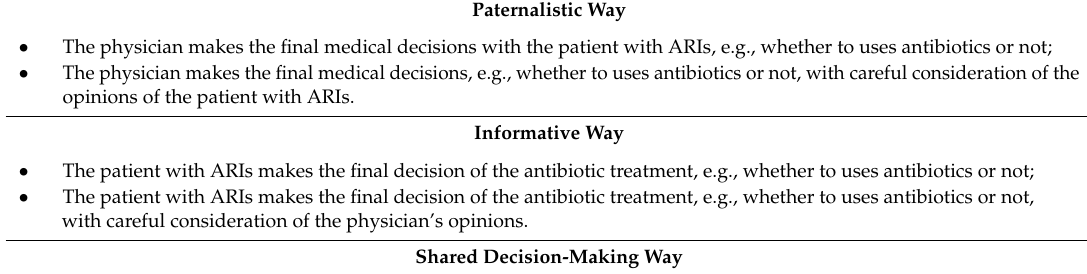
Table 1. Physicians’ intention of involving patients in medical decisions with patients with acute respiratory infections (ARIs) based on Control Preference